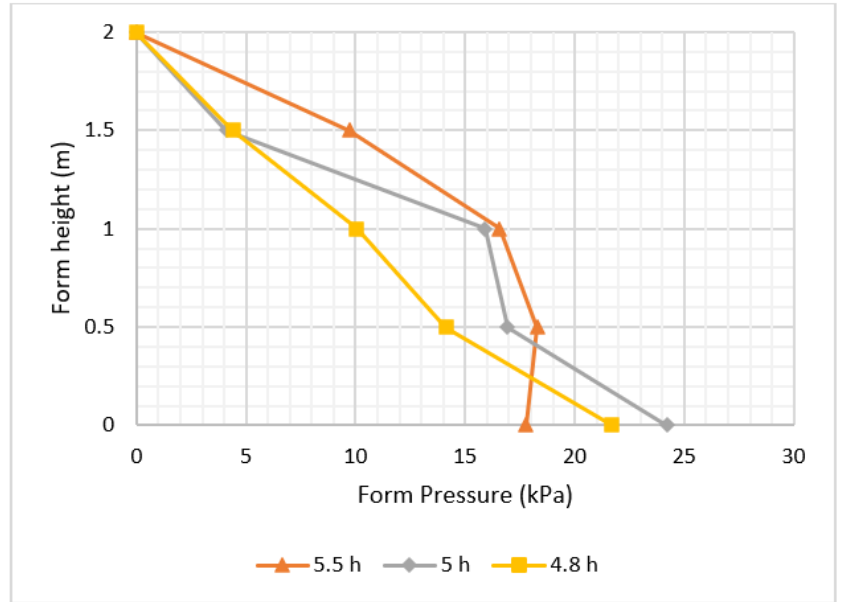
Figure 11. The effect of concrete setting time on pressure.